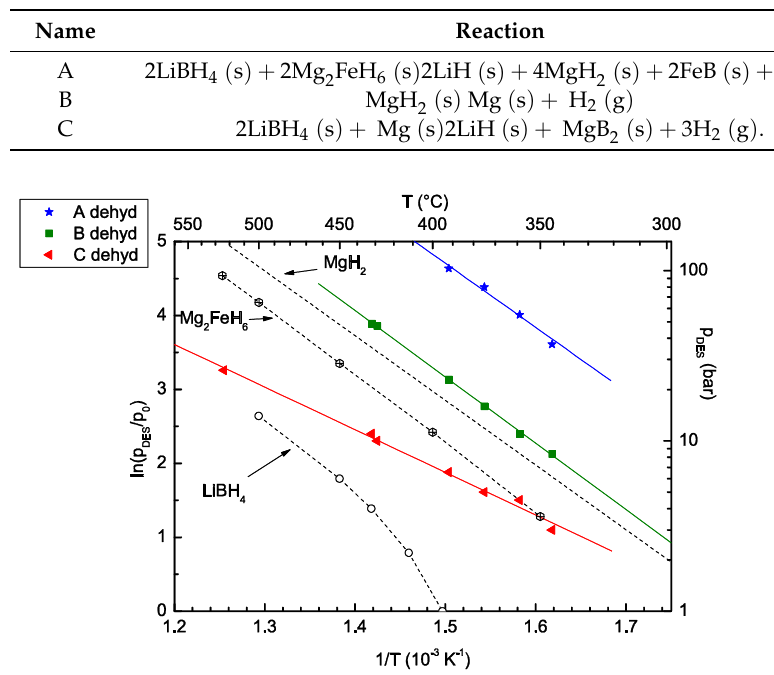
Figure 1. Van ’t Hoff plots of the 2LiBH 4 –Mg 2 FeH 6 composite’s three-step dehydrogenation reactions (A, B, and C) (full symbols including best fit lines). Open symbols represent literature data for the decomposition of each individual compound—LiBH 4 (circles) [19] and Mg 2 FeH 6 (squares) [5]—while dotted lines denote the MgH 2 dehydrogenation data [20]. Figure adapted, with permission, from [11].